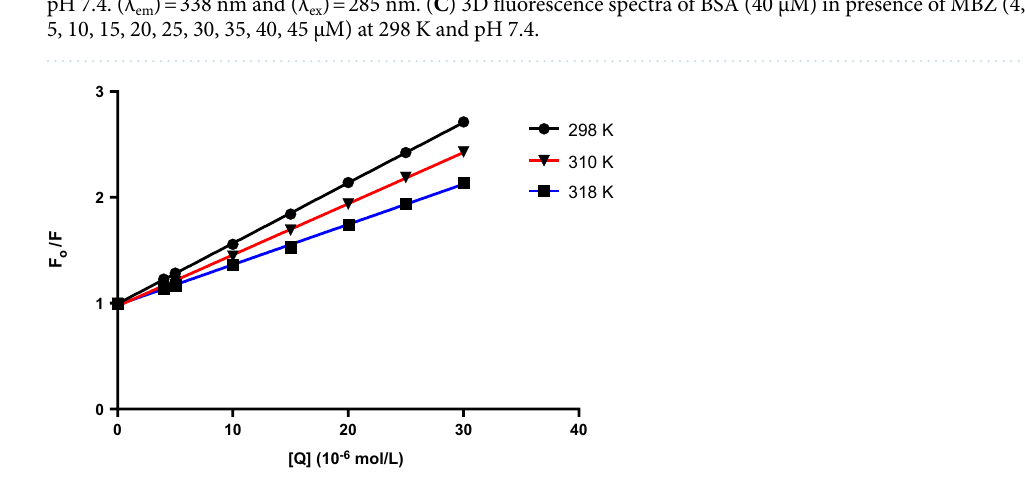
Figure 4. Stern–Volmer plots for BSA-MBZ system at various